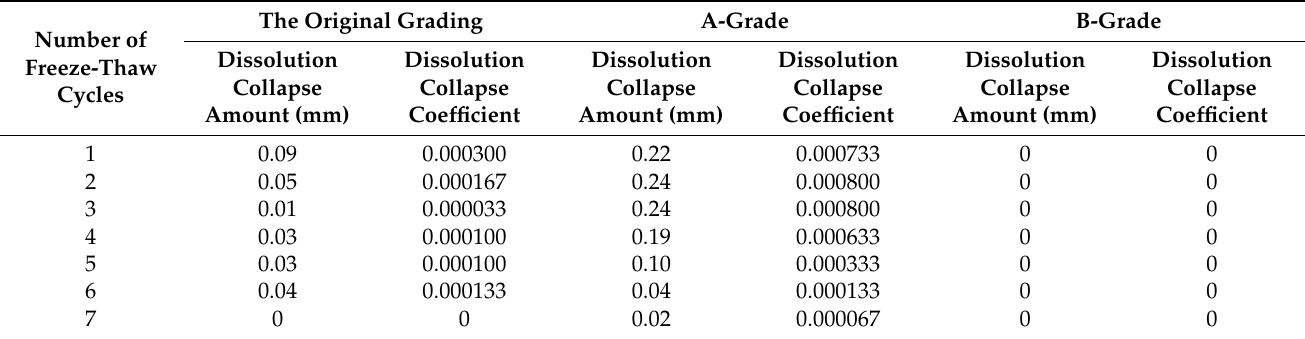
Table 5. The amount and coefficient of dissolution of soil